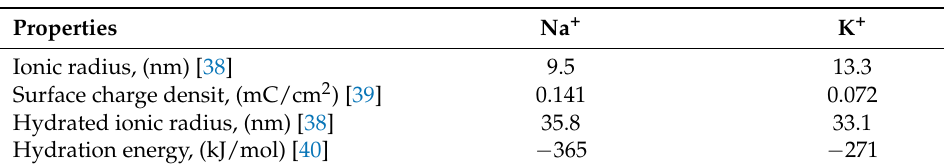
Table 3. The properties of K + and Na + .